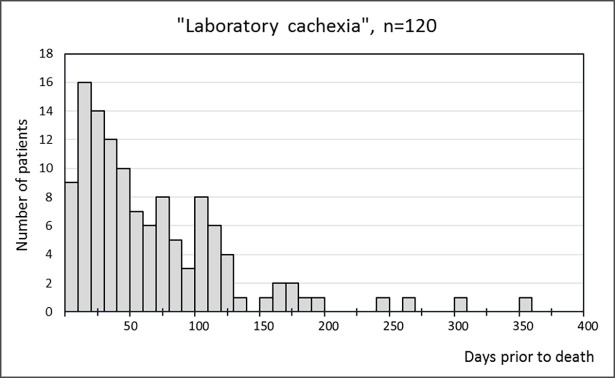
Laboratory cachexia.Number of days prior to death that the criteria for “laboratory cachexia” was first fulfilled for the 120 patients who at some point fulfilled the criteria.